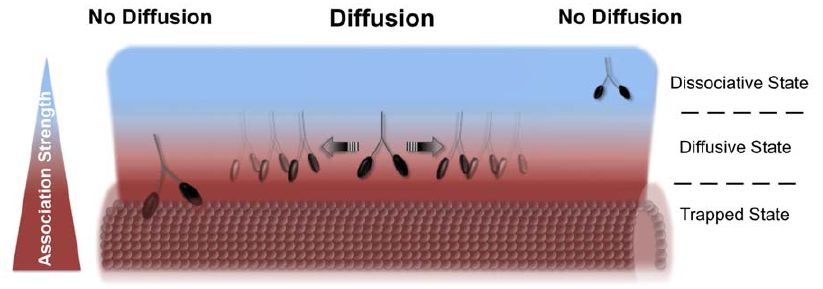
Figure 6. The balance between attraction forces determines the diffusive state of myosin V on microtubules. (Left part) Strong attraction forces prevent microtubule-bound myo V molecules from advancing to the diffusive state. This Trapped State is achieved, if in addition to electrostatic also non-ionic attraction forces become increasingly dominant ( Minus4 and Minus13 on S-microtubules). (Middle part) Diffusion takes place if for myo V the attraction toward the microtubule is of moderate strength. This Diffusive State in general is achieved when attraction and repulsion outweigh each other. Two different possibilities might account for that behavior. First, electrostatic and non-electrostatic interaction forces at the myo V binding-interface are well-balanced ( Wildtype on untreated and S-microtubules); second, strong loop 2-derived ionic attraction is dominated by ionic repulsion elements (E-hooks) on the microtubule binding-interface ( Minus4 on untreated microtubules). (Right part) Weak attraction toward microtubules prevents myo V from binding effectively to the filament, and hence diffusion becomes unlikely. This Dissociative State is given, if electrostatic repulsion via hydrophilic surface structures (E-hooks) becomes predominant ( Minus13 on untreated microtubules). Red and blue colors indicate strong and weak attraction forces toward the microtubule surface,